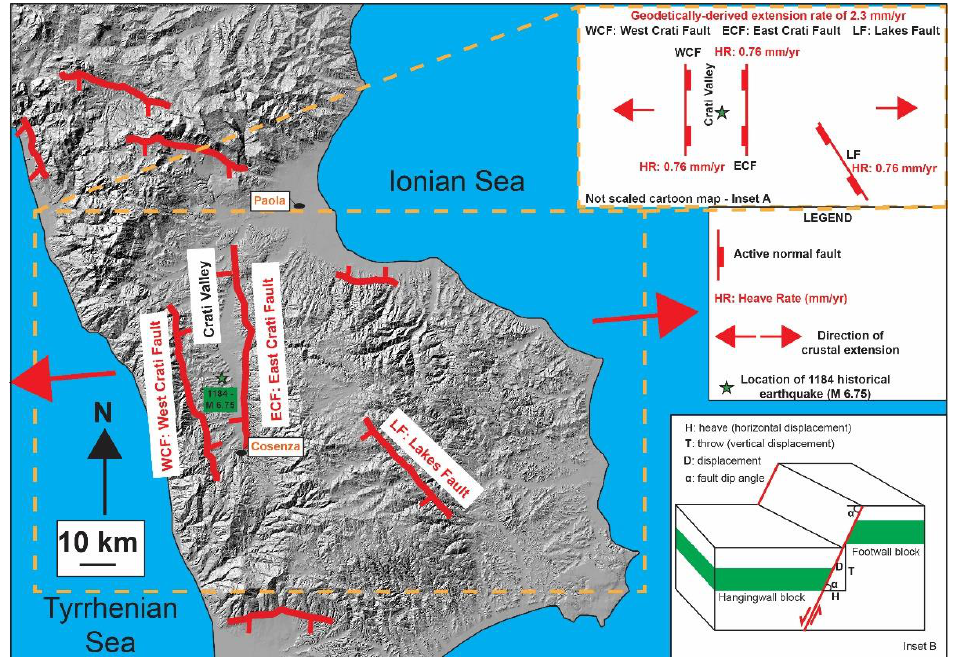
Figure 9. A schematic structural map is shown where active faults are accommodating our geodet- ically derived crustal extension of 2.3 mm/yr across the strike of the E-dipping West Crati Fault and throughout northern Calabria. The green star indicates the location of the 1184 “Valle del Crati” earthquake (M 6.75) from the INGV historical catalogue [29]. Inset A shows a no-scaled cartoon where homogenous heave rates (HR) from computed extension rates are assigned among the active faults such as the West Crati Fault, East Crati Fault, and the Lakes Fault. Inset B shows a scheme of a normal fault with the three components where the deformation is measured and the fault dip angles: heave, throw, and displacement. Note that for a 45° fault dip, angle, throw, and heave will be equal.